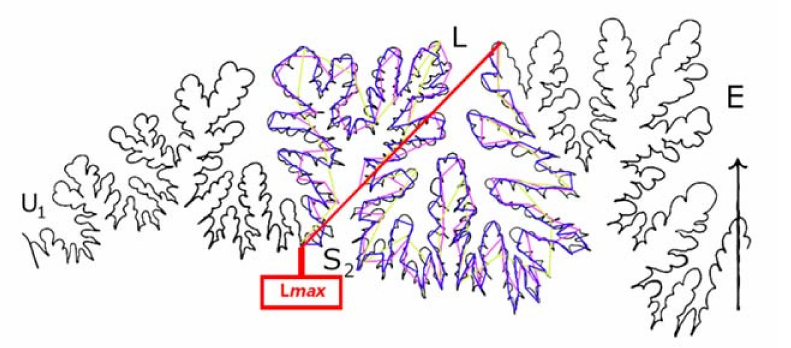
Figure 4. Step count of Eogaudryceras numidum suture using the LLS Method as described using fractions of the LLS length ( L max ) as rule sizes. Green is 1/5, magenta is 1/10, and blue is 1/15. Eogaudryceras numidum suture redrawn by KM from Figure 31E in